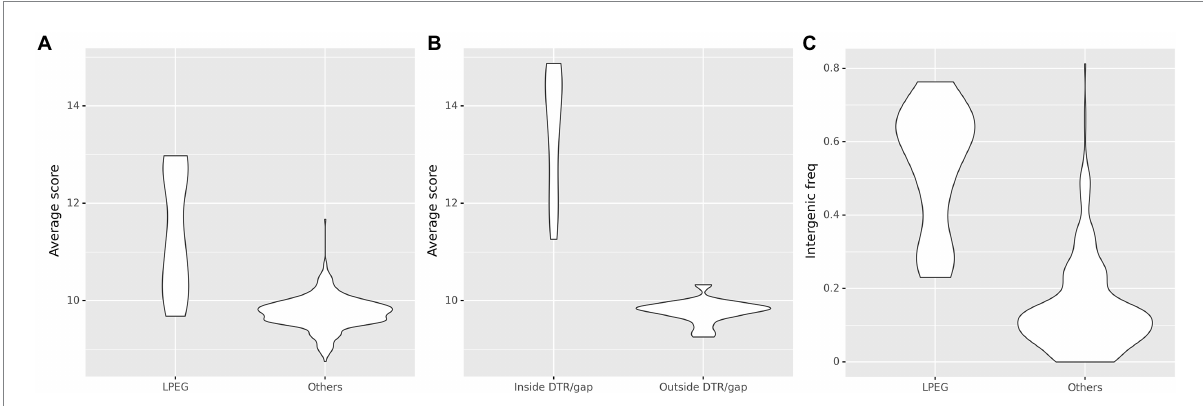
FIGURE 7 Comparison of predicted CtrA-binding sites between LPEG and control phages. (A) Comparison of the distribution of the average PSSM score for predicted CtrA-binding sites over the entire genome, in LPEG phages and all the other analyzed phage genomes. (B) Comparison of the distribution of the average PSSM score for predicted CtrA-binding sites identified within and outside DTR/gap regions in LPEG phage genomes. (C) Comparison of the distribution of intergenic frequency for predicted CtrA-binding sites (defined as the proportion of predicted CtrA-binding sites identified in non-coding regions) in LPEG and all the other analyzed phage genomes.